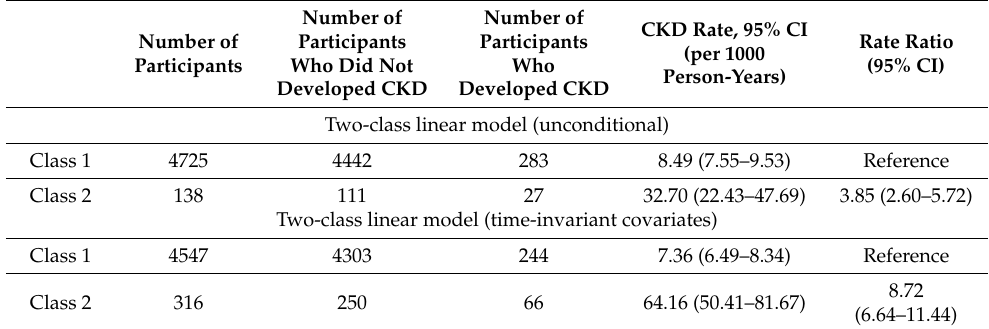
Table 2. Comparison of chronic kidney disease rates of participants assigned Class 1 and 2 using the two-class linear model with and without time-invariant